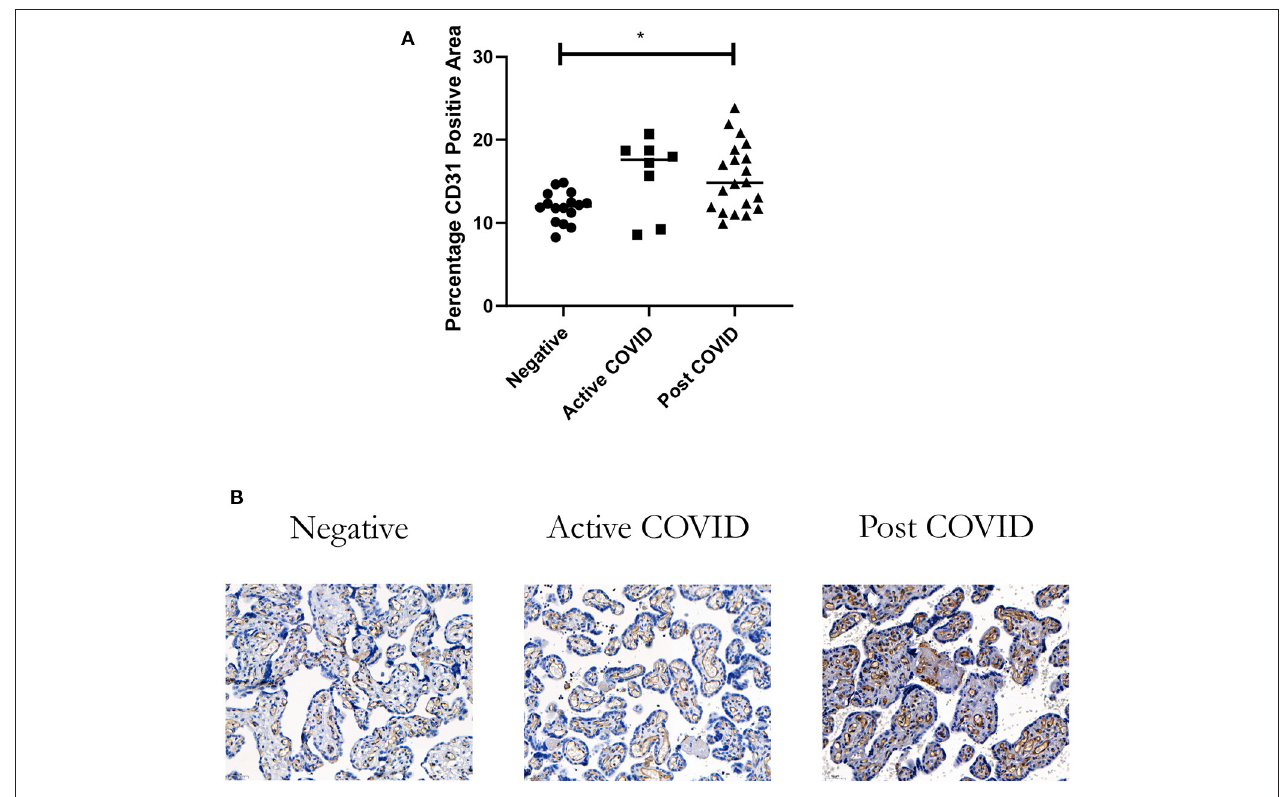
FIGURE 2 | Vascularity of placentas from women who had COVID-19 during their pregnancy. (A) There was a significant increase in the percentage vascularity in the placentas of women in the Post COVID group compared to controls (* p = 0.026). There was no difference in placental vascularity in the Active COVID group compared to controls ( p = 0.06). (B) Representative image magnification X20. Kruskal-Wallis, Active COVID n = 8, Post COVID n = 20, and controls n = 16.